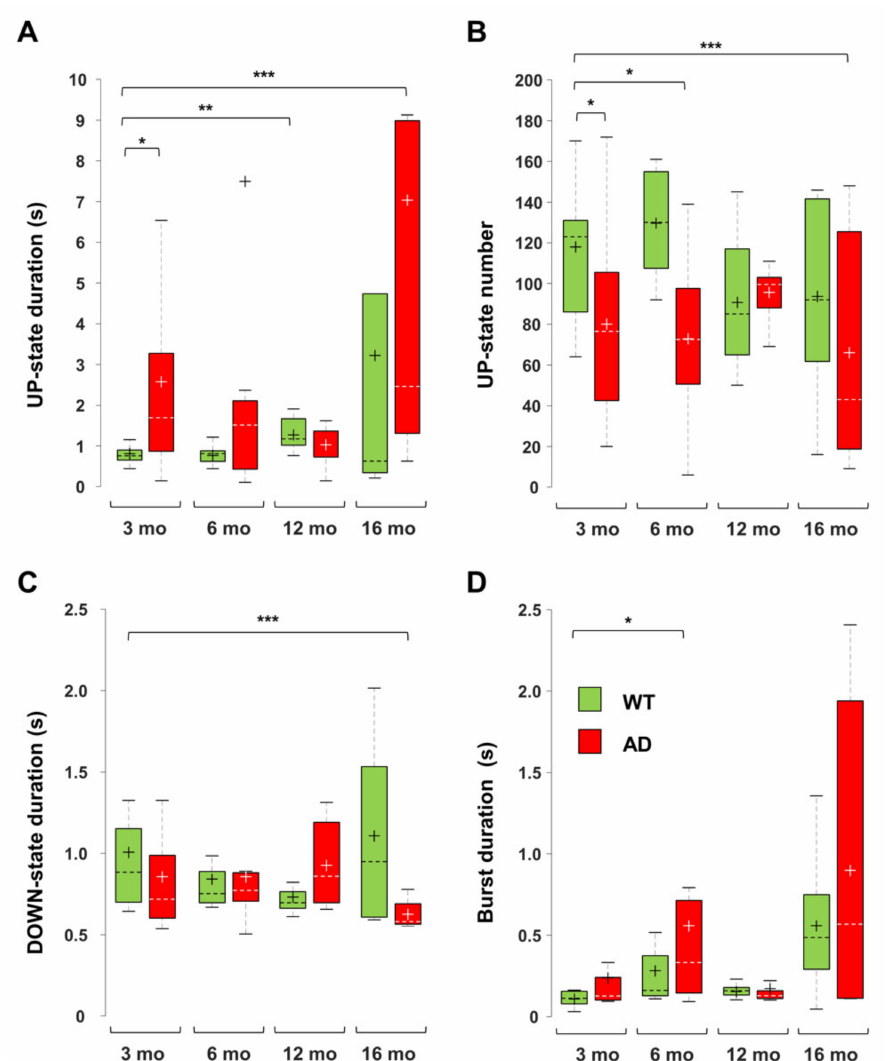
Figure 9. Changes in UP-DOWN states and burst duration in AD and WT mice across ages. Boxplots of UP-state duration ( A ), UP-state number ( B ), DOWN-state duration ( C ) and burst duration ( D ), measured in CA1 sr-lm (1500 µ m) of AD and WT mice at different ages (* p < 0.05; ** p < 0.01; *** p < 0.001). The numbers of mice per genotype and age cohort are those indicated in Figure